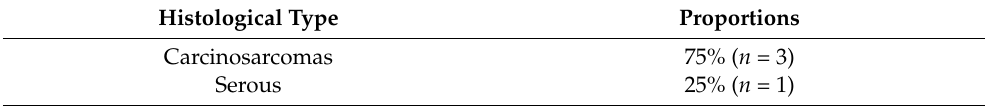
Table 9. Cases presenting an aneusomy for CEP17 (polysomy-like) according to their histological